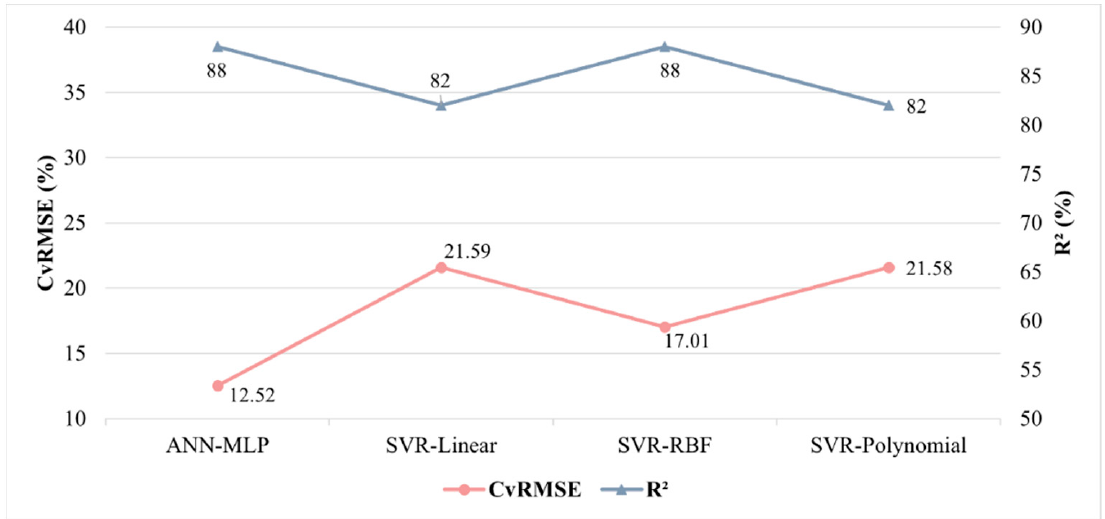
Figure 14. Comparison of the CvRMSE and R 2 for each LNG consumption prediction model.